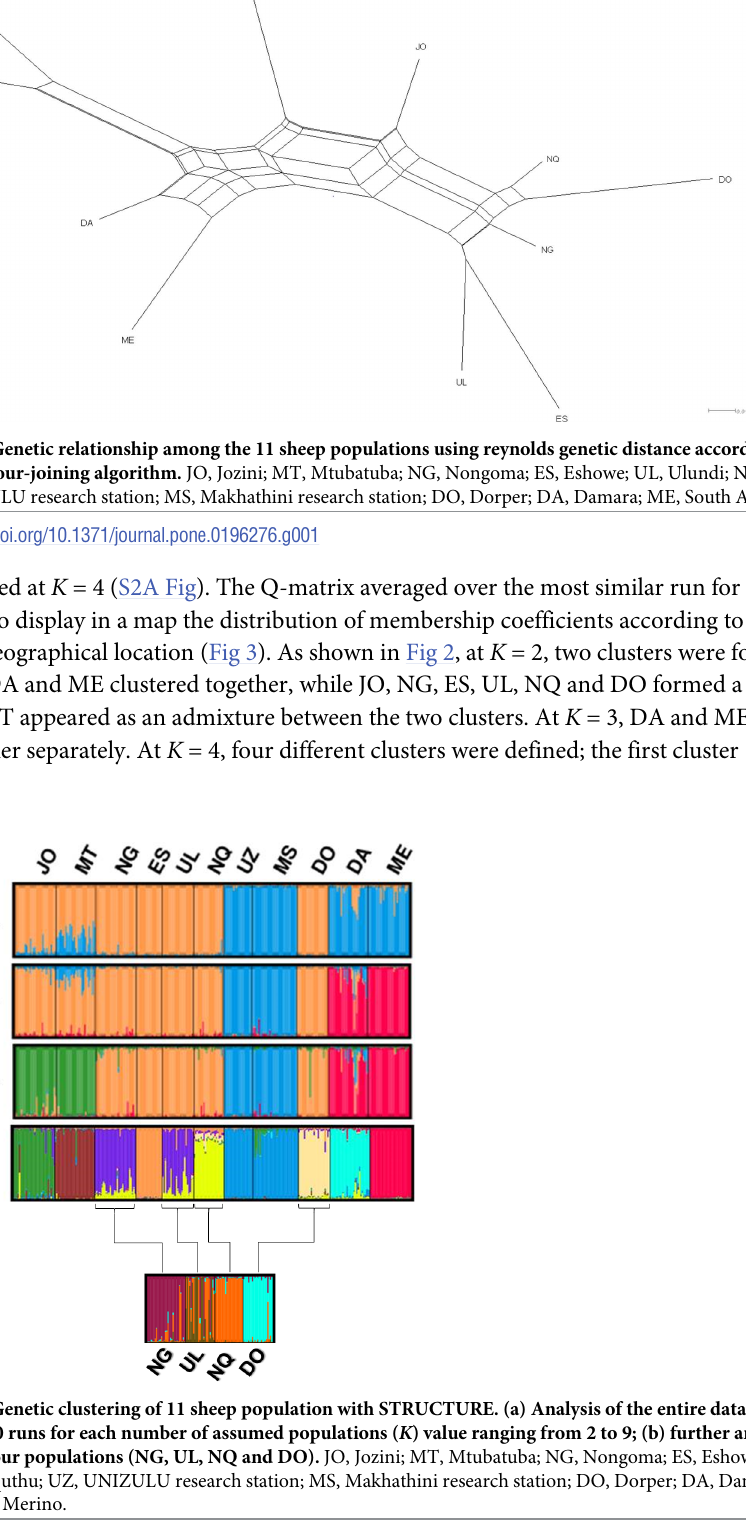
Fig 2. Genetic clustering of 11 sheep population with STRUCTURE. (a) Analysis of the entire data set obtained from 10 runs for each number of assumed populations ( K ) value ranging from 2 to 9; (b) further analysis obtained from four populations (NG, UL, NQ and DO). JO, Jozini; MT, Mtubatuba; NG, Nongoma; ES, Eshowe; UL, Ulundi; NQ, Nquthu; UZ, UNIZULU research station; MS, Makhathini research station; DO, Dorper; DA, Damara; ME, South African